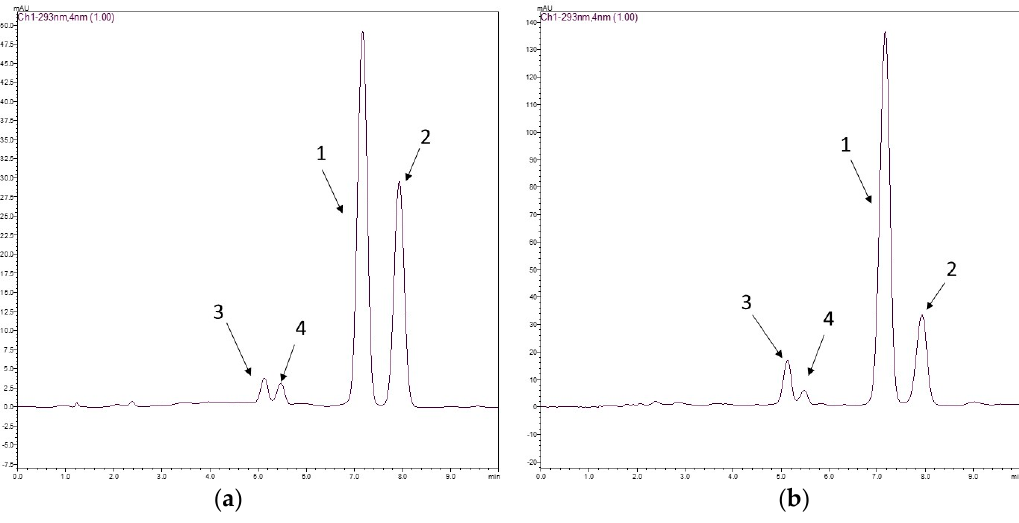
Figure 2. Typical chromatograms of D. utilis roots extract ( a ) and D. rufescens var. urucu roots extract ( b ) for determination of rotenone 1 and deguelin 2 . Chromatographic conditions used: a mixture of acetonitrile/water (60:40; v / v ) as a mobile phase and as stationary phase a Gemini ® C18 column (150 × 4.6 mm, 5.0 μ m). The injection volume was 20 μ L, and the flow rate 1.0 mL min − 1 at 293 nm.